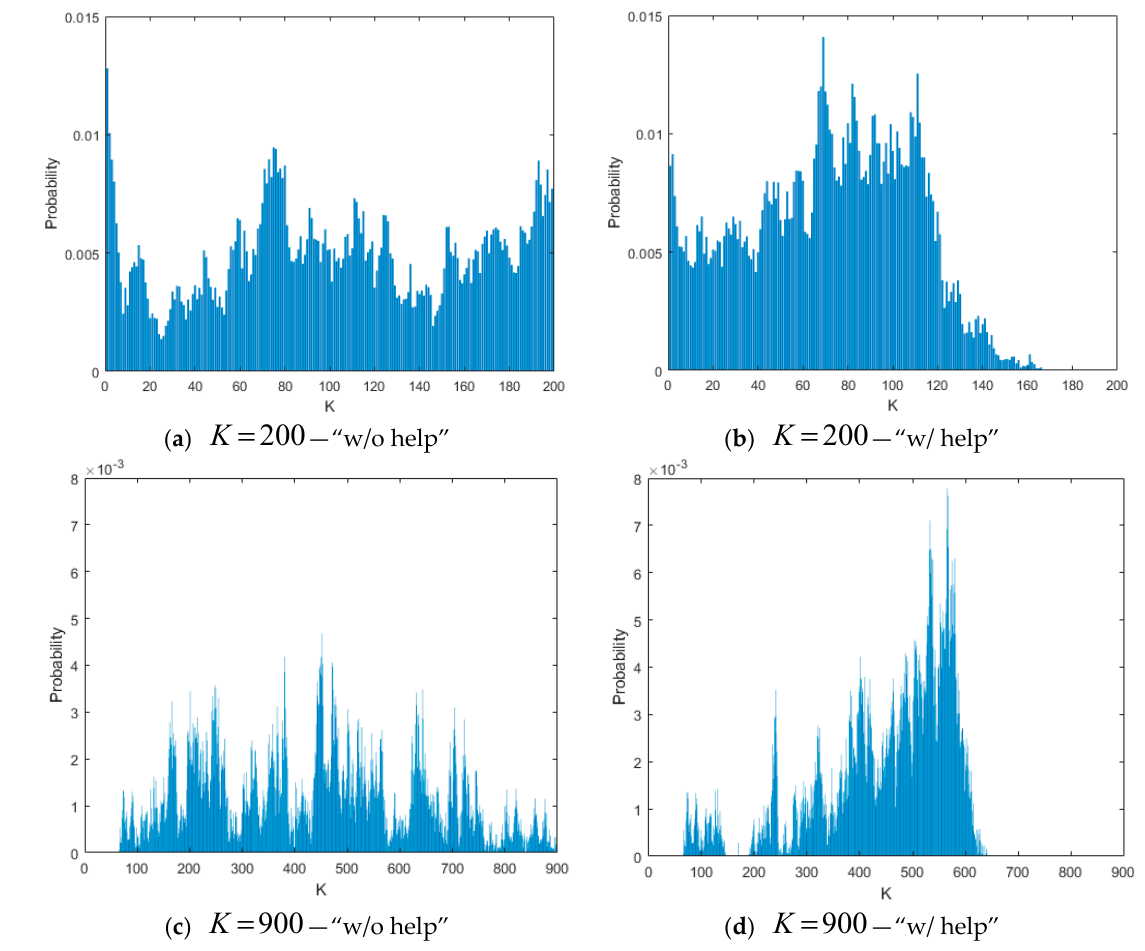
Figure 7. Normalized histograms of the job queue